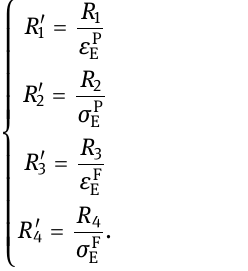
Table 4: The solved GTN parameters at di ff erent strain rates Strain rate